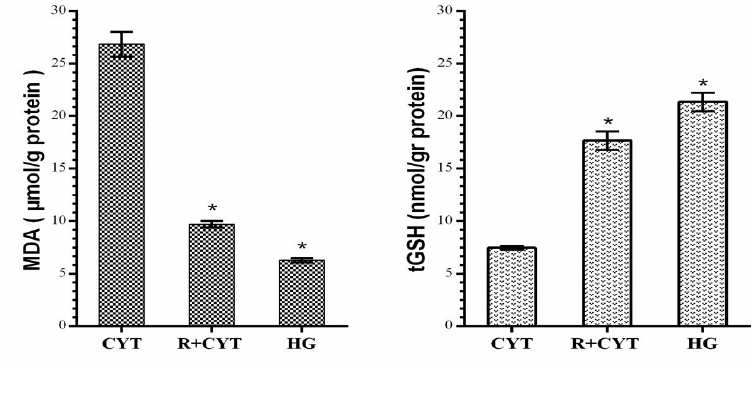
Figure 4. Total oxidant status (TOS) and total antioxidant status (TAS) in the lung tissues of the rats in the control (HG), cytarabine (CYT) and rutin+cytarabine (R+CYT) groups. *p<0.0001 according to control (HG) group, **p<0.0001 according to cytarabine (CYT).